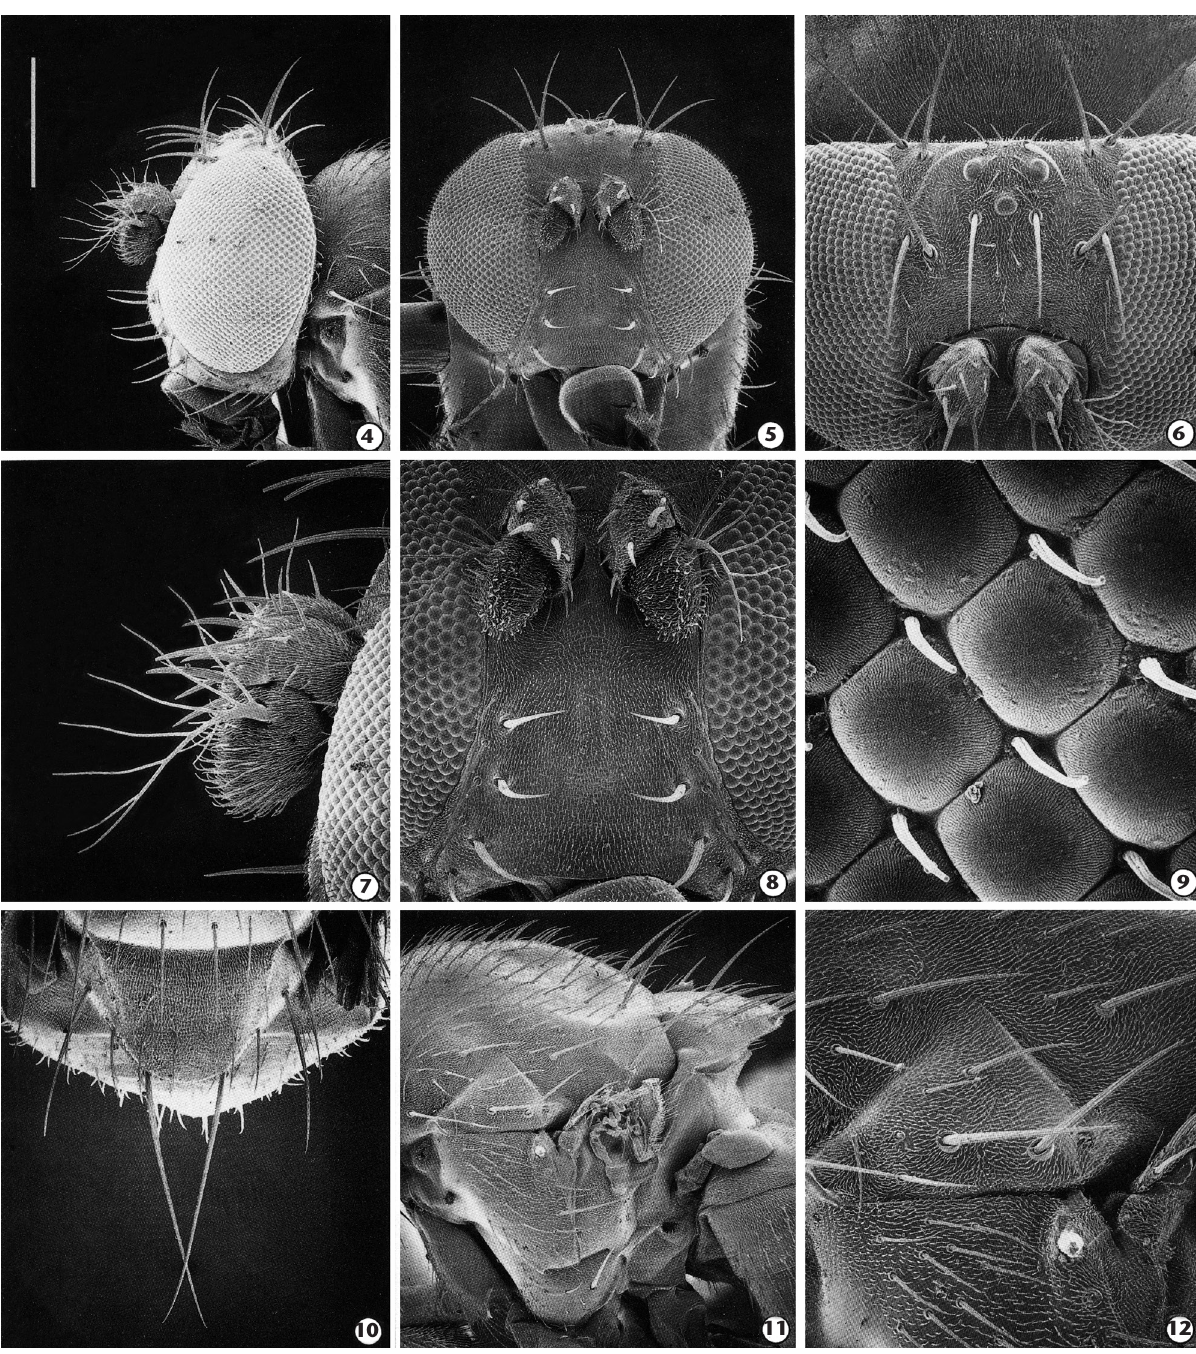
15Figures 4-12. Scanning electron micrographs of Orasiopa ( Reymontopa ) mera , male (Belize, Stann Creek District: Tobacco Range; scale bar in parentheses): (4) head, lateral view (250 µm); (5) same, anterior view (250 µm); (6) frons, anterodorsal view (150 µm); (7) antenna, lateral view (100 µm); (8) face, anterior view (120 µm); (9) eye with interfacetal setulae, lateral view (10 µm); (10) scutellum, dorsal view (176 µm); (11) pleuron, lateral view (250 µm); (12) notopleuron, lateral view (100